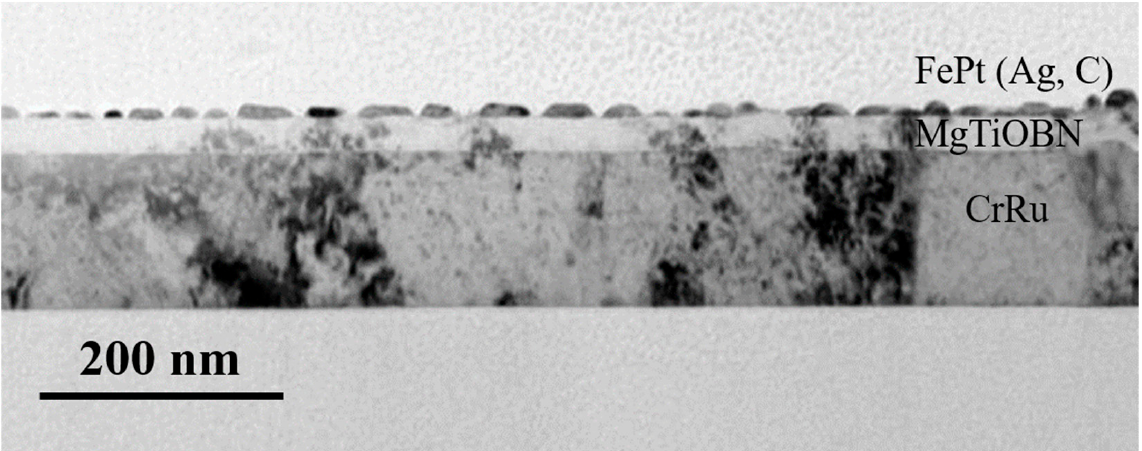
Figure 8. cross-section TEM image of FePtCAg/MgTiOBN/CrRu films. The C atoms are almost distributed in the grain boundary area and the BN atoms are both clearly observed in the FePt lattice. This was monitored by overlapped TEM images in Figure 9 and we found that the N atoms are located in the FePt grains and part of them are distributed in the boundaries. To observe the N distribution clearly, the N image was mapped with the FePtCAg grains image presented in Figure 10. The composition and elements distribution are summarized into two parts, (1) The BN was truly diffused up from the MgTiOBN intermediate layer to the FePt lattice and part of them are formed in amorphous BN binding and the other BN atoms are bonded to Fe atoms around the grains shell. (2) The C atoms are almost segregated at the FePt grains boundaries. To further understand the other elements’ distribution in FePtCAg/MgTiOBN film, the energy dispersive X-ray (EDX) was applied to analyze the